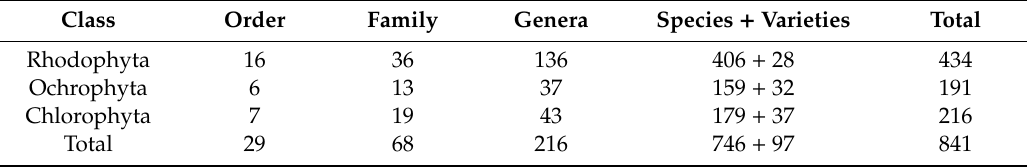
Table 1. Phylum-wise distribution of seaweed taxa in Indian